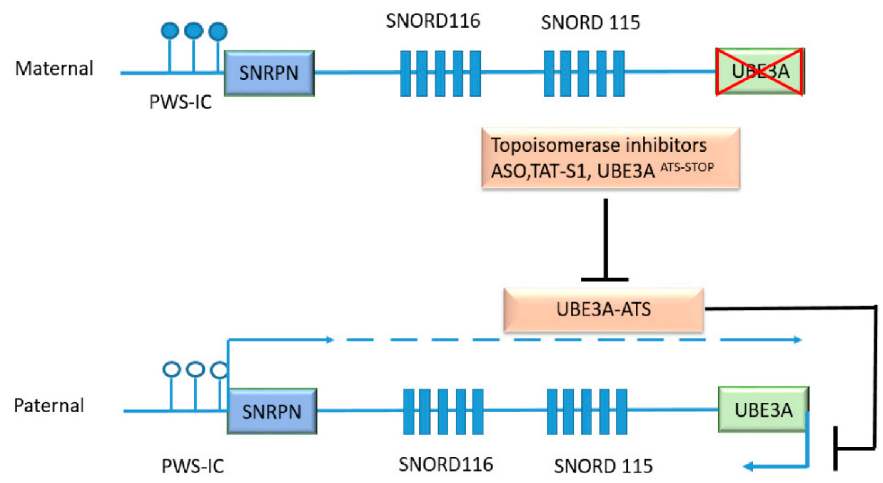
Figure 4. UBE3A-ATS as a mediator of genomic imprinting in neurons and as a therapeutic target. UBE3A-ATS is a large transcript which initiates at the Prader-Willi syndrome imprinting center (PWS-IC). The PWS-IC is not methylated (clear circles) in the paternal allele and allows the initiation of transcription. The progression of transcription through UBE3A-ATS locus is responsible for the paternal imprinting of UBE3A in neurons. UBE3A-ATS includes the protein-coding gene SNRPN and genes encoding small nucleolar RNAs SNORD 116 and SNORD 115 . Targeting UBE3A-ATS by topoisomerase inhibitors, antisense oligonucleotides, artificial transcription repressor TAT-S1, or insertion of stop codon UBE3A ATS-STOP could restore UBE3A expression in AS neurons. The maternal PWS-IC is methylated (dark circles) and the expression of UBE3A-AS is silenced.